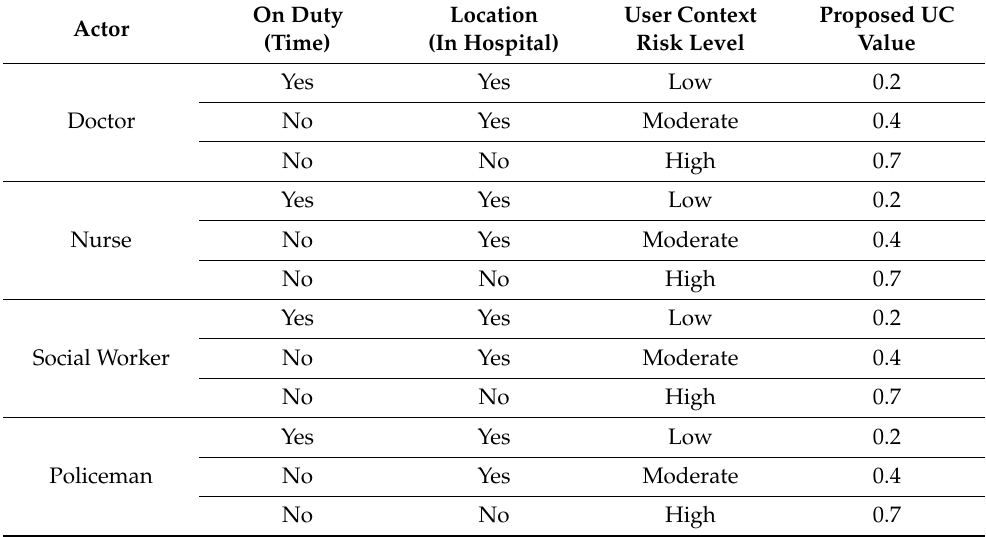
Table 8. The risk value of user context of various actors involved in this